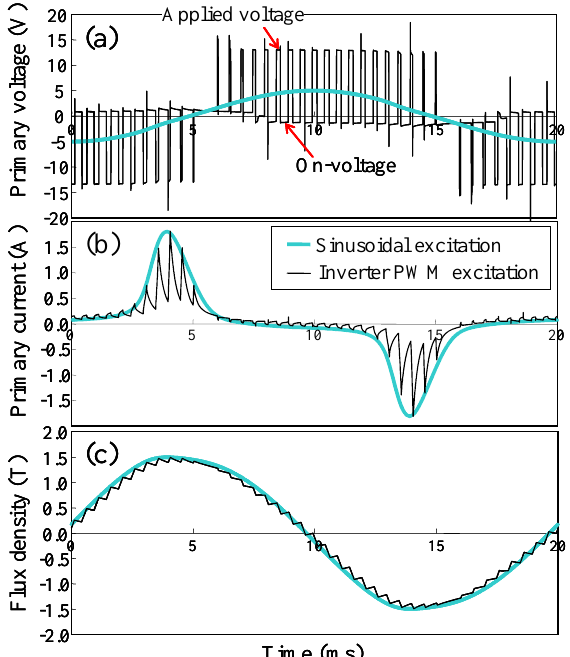
Figure 6. Waveforms of ( a ) voltage, ( b ) current, and ( c ) flux density, at maximum flux density of 1.5 T, fundamental frequency of 50 Hz, carrier frequency of 1 kHz, and modulation index of 0.4.